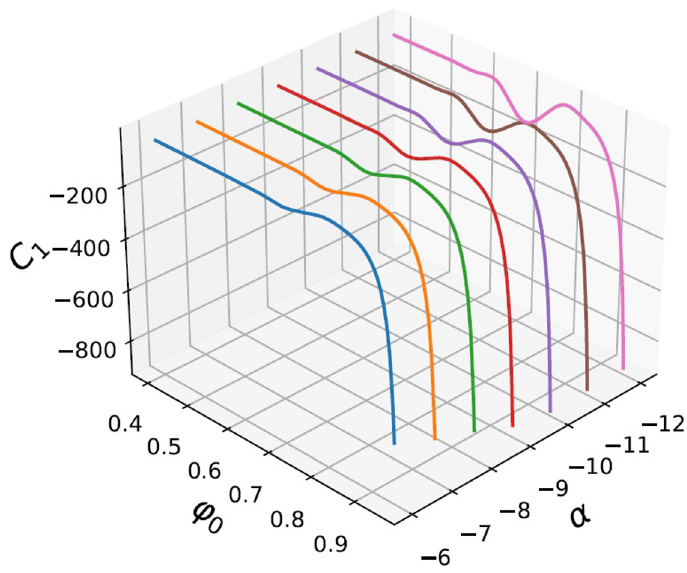
Figure 22 . The integration constant C 1 as a function of the two parameters, ϕ 0 and α , for Bolt end-point solutions.